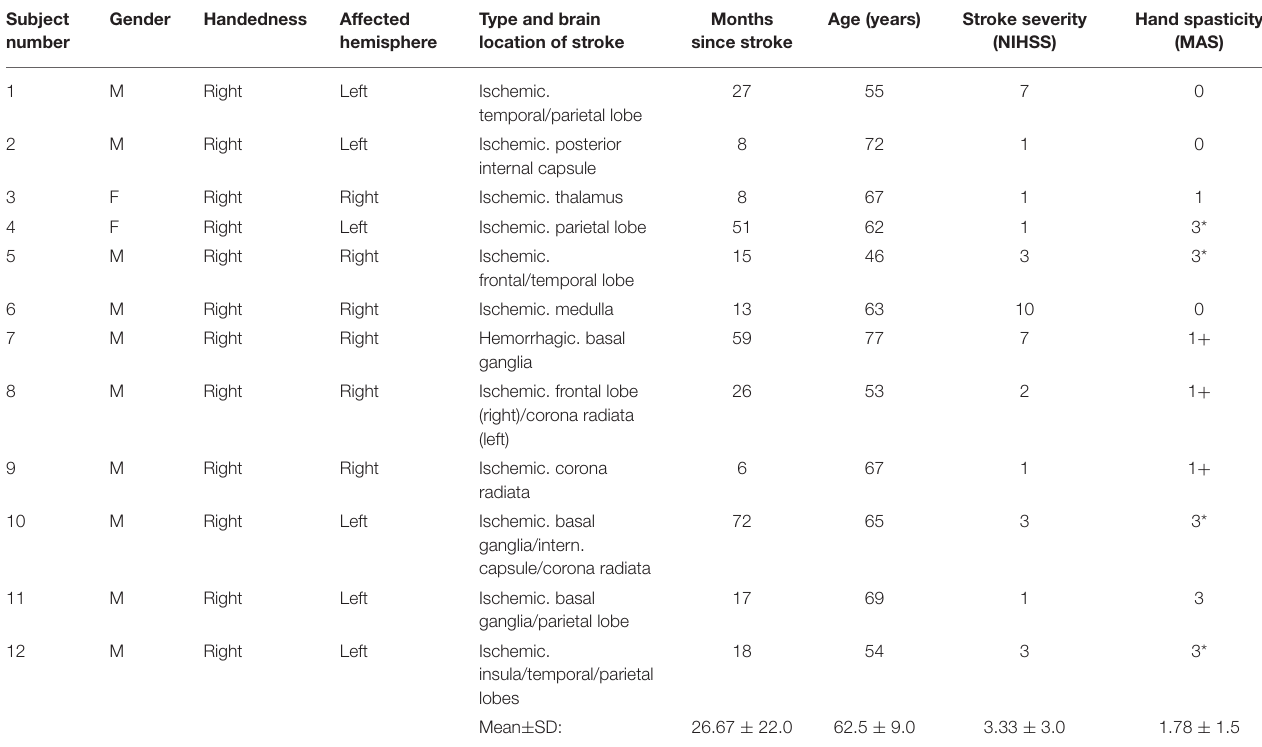
TABLE 1 | Participants